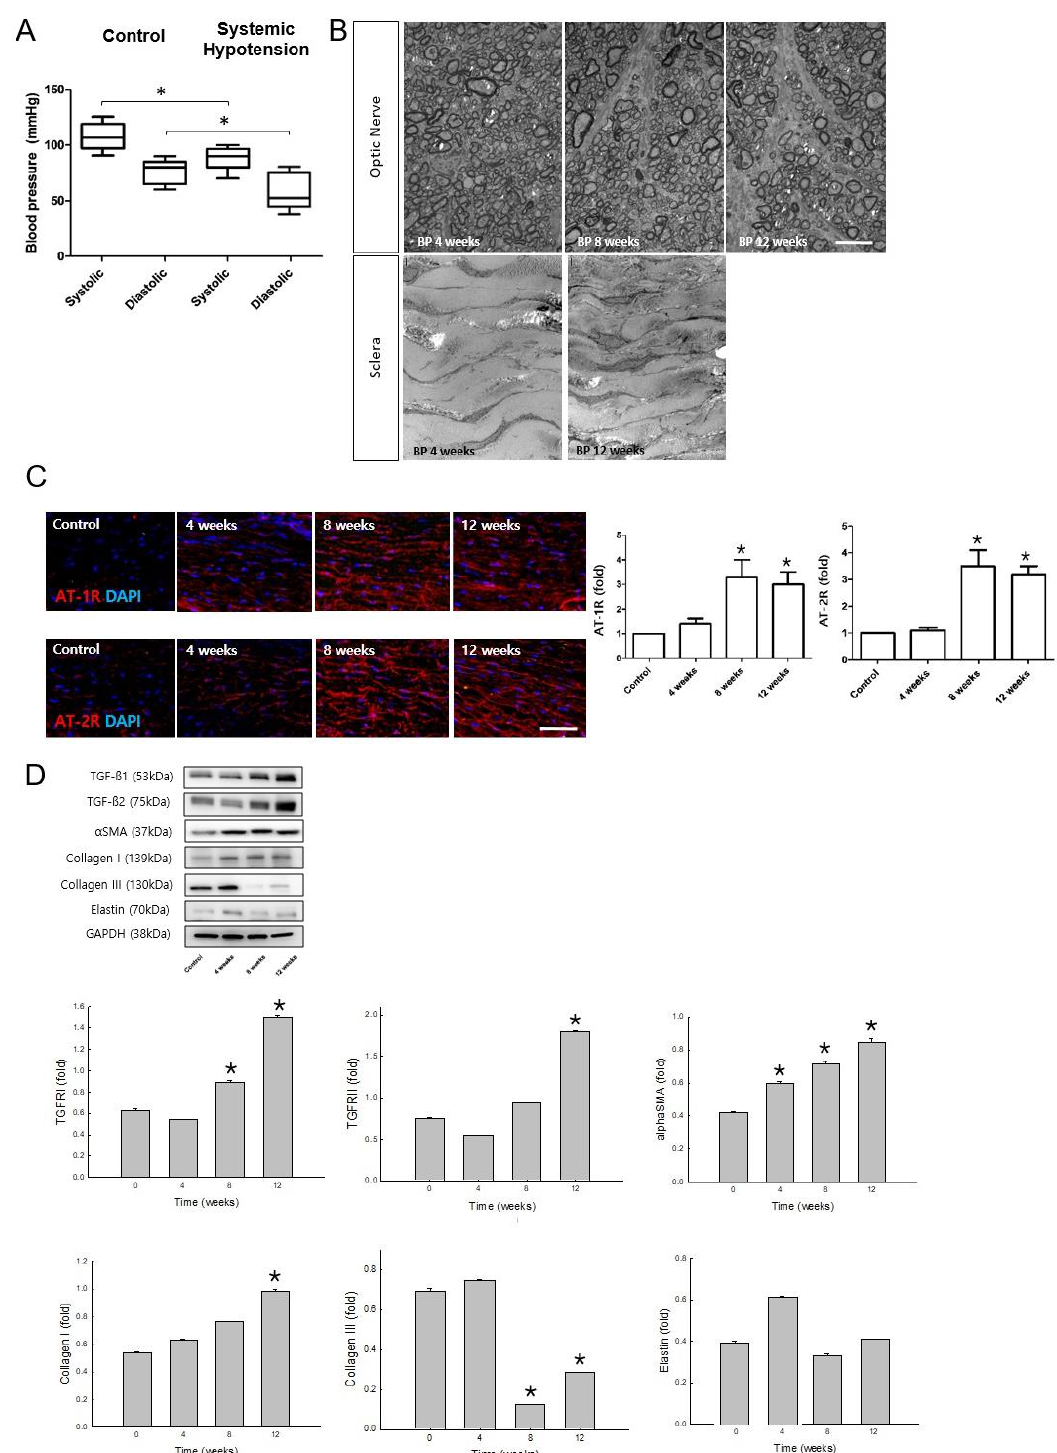
Figure 1. ( A ) Systolic and diastolic blood pressure (BP) of control and systemic hypotensive rats. Rats administered diuretics exhibited lower systemic BP than controls. For BP measurements, n = 6 for control and n = 6 for systemic hypotension; total n = 12. The bar represents mean ± SD. There were statistically significant differences between systolic and diastolic BP of control and systemic hypotension groups, all p < 0.001 ( B ) Transmission electron microscopic evaluation of the optic